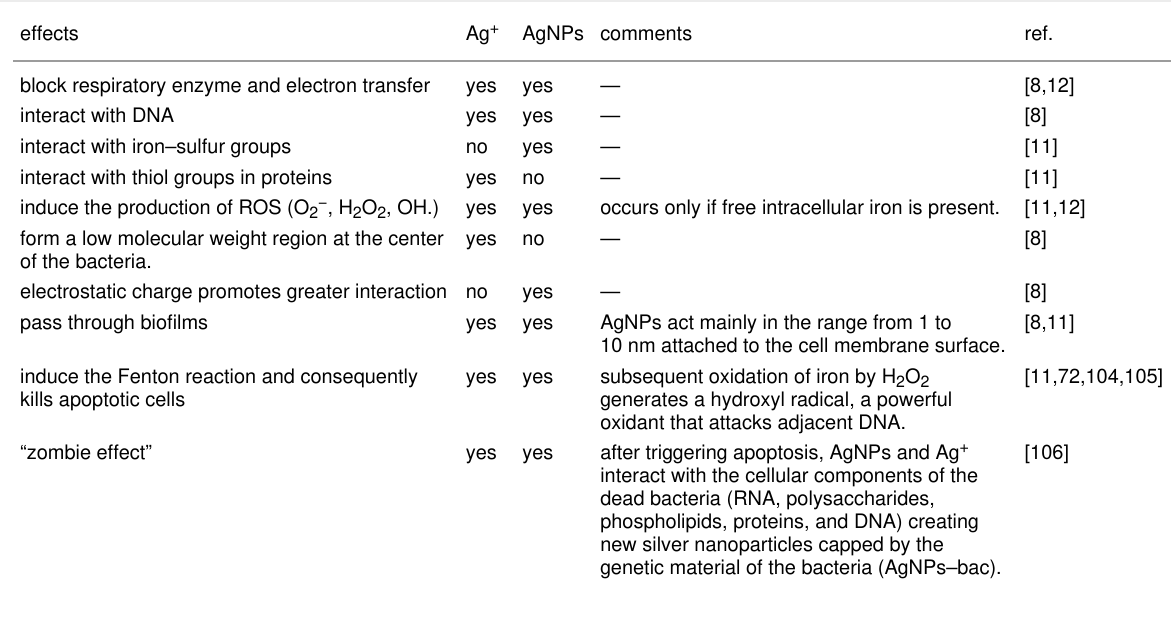
Table 1: Effects of silver ion (Ag + ) and AgNPs on bacterial